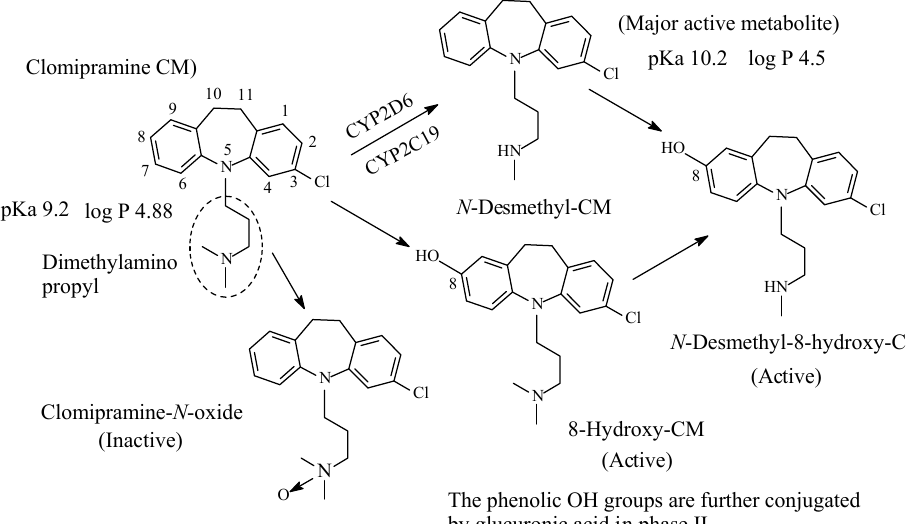
Figure 5. Metabolic pathways of clomipramine.